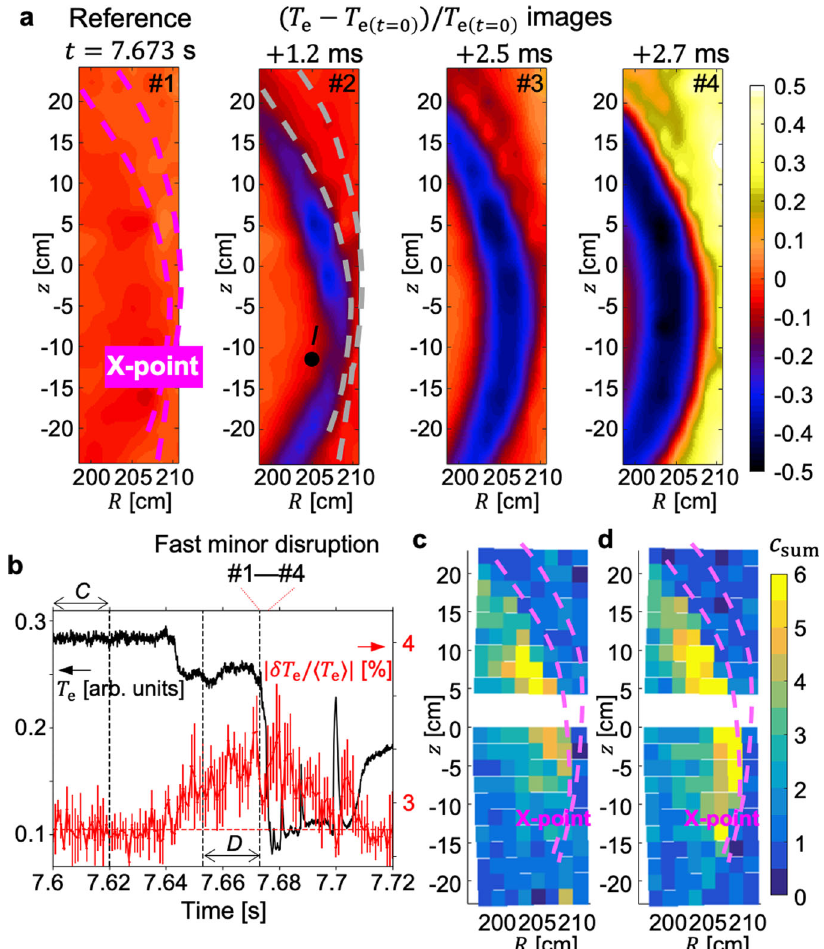
Fig. 5 Turbulence enhancement at the reconnection site. a The 2D relative change of T e around the magnetic island during a short period of T e collapse. The temporal range of #1 – #4 are indicated by red dotted lines at the top of ( b ). b T e measurements (black) at position I (marked on the #2 image in a ) and the root- mean-square amplitude of the normalized T e fl uctuation (red) at the X-point. c , d The 2D strength of the T e turbulence for the period C and D ,